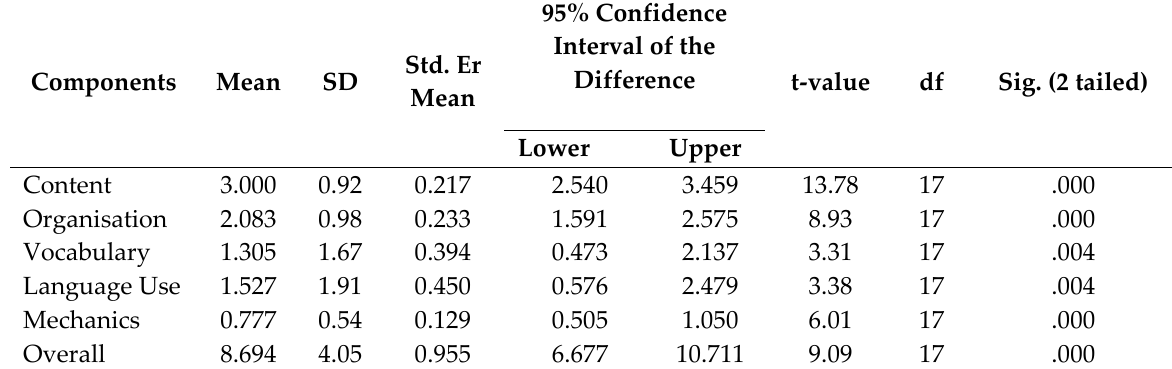
Table 3. Comparison of pre-and post-treatment writing scores (n=